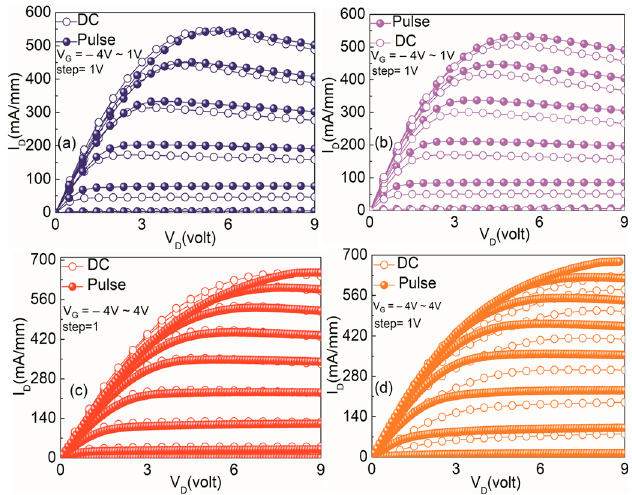
Figure 6. Comparison of pulsed I D -V D characteristics of UV/O 3 -treated C-HEMT ( a ) after and ( b ) before HfSiO X passivation and MOS-HEMT ( c ) after and ( d ) before HfSiO X